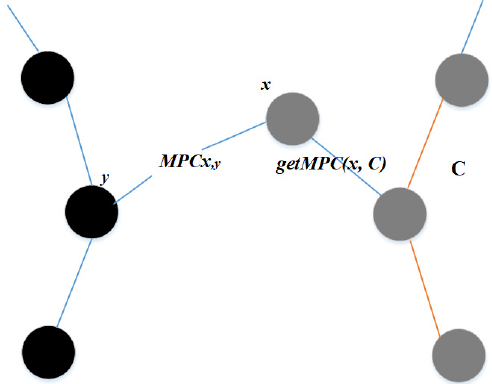
Figure 7. Scenario 2, where x is not a member of C.